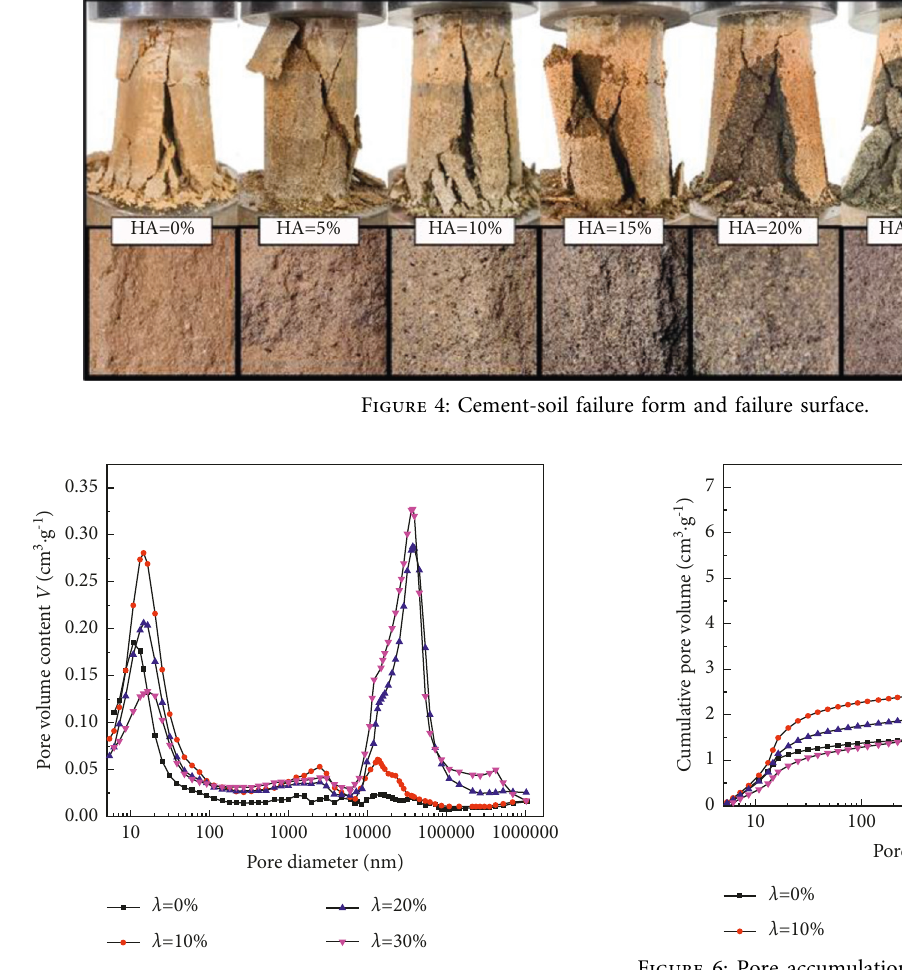
Figure 5: Pore distribution of cement-soil samples with different HA content λ .